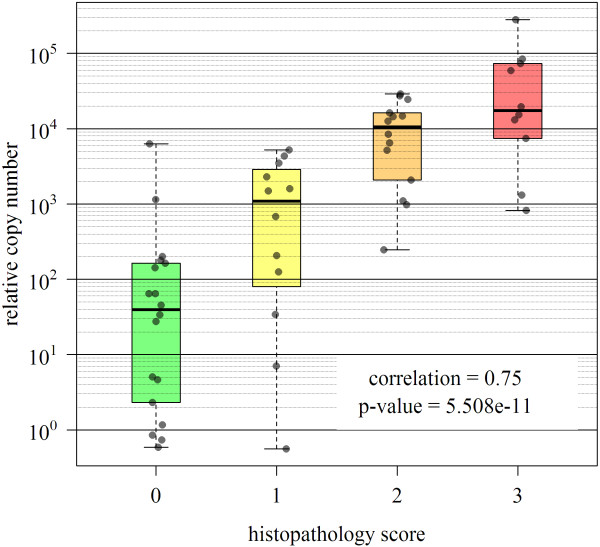
Correlation between cardiac histopathology and viral loads. Histopathology scores were correlated against relative copy numbers of PMCV in infected fish (n = 6) from all time points. Data points are plotted randomly across the box area in x-direction for better visualization. Correlation coefficient and p-value were calculated for log-transformed copy numbers.